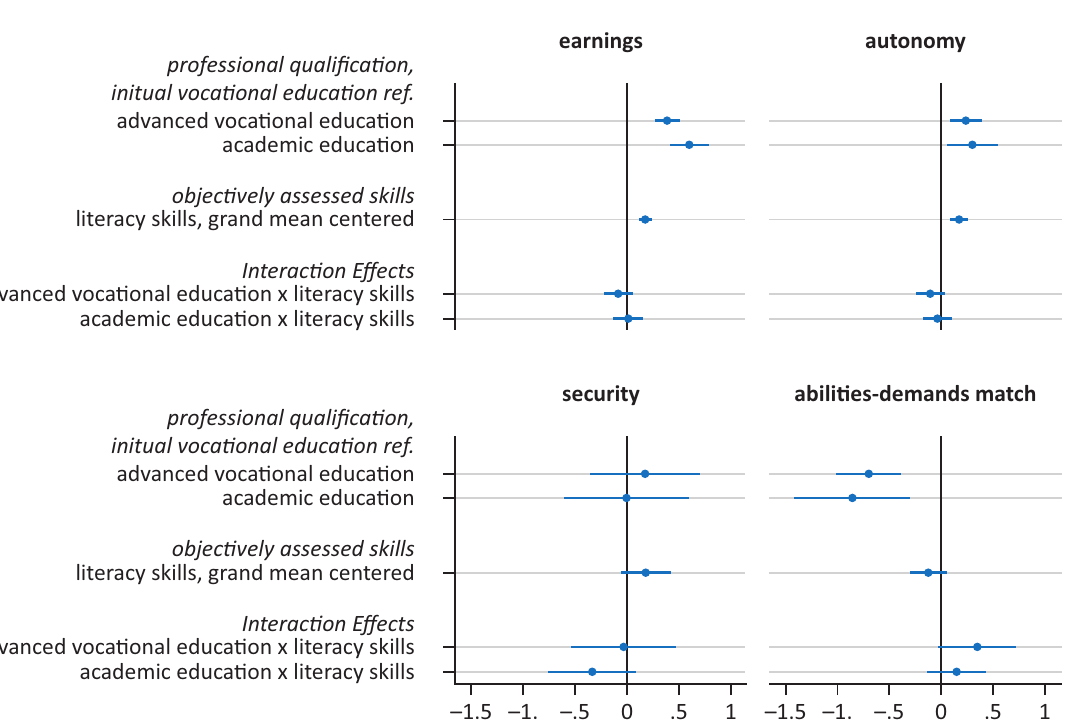
Figure 2. Associations of professional qualification and literacy skills and interactions between the two with four in- dicators of job quality. Notes: PIACC 2012, continuous variables standardized; N(earnings) 2,084, N(autonomy) 2,216, N(security) 2,218, N(abilities-demands match) 2,217; the axis refers to either changes in S.D. (earnings and autonomy) or logits (security and abilities-demands match); controls: gender, migration, school qualification, age, age-squared, firm size, parental